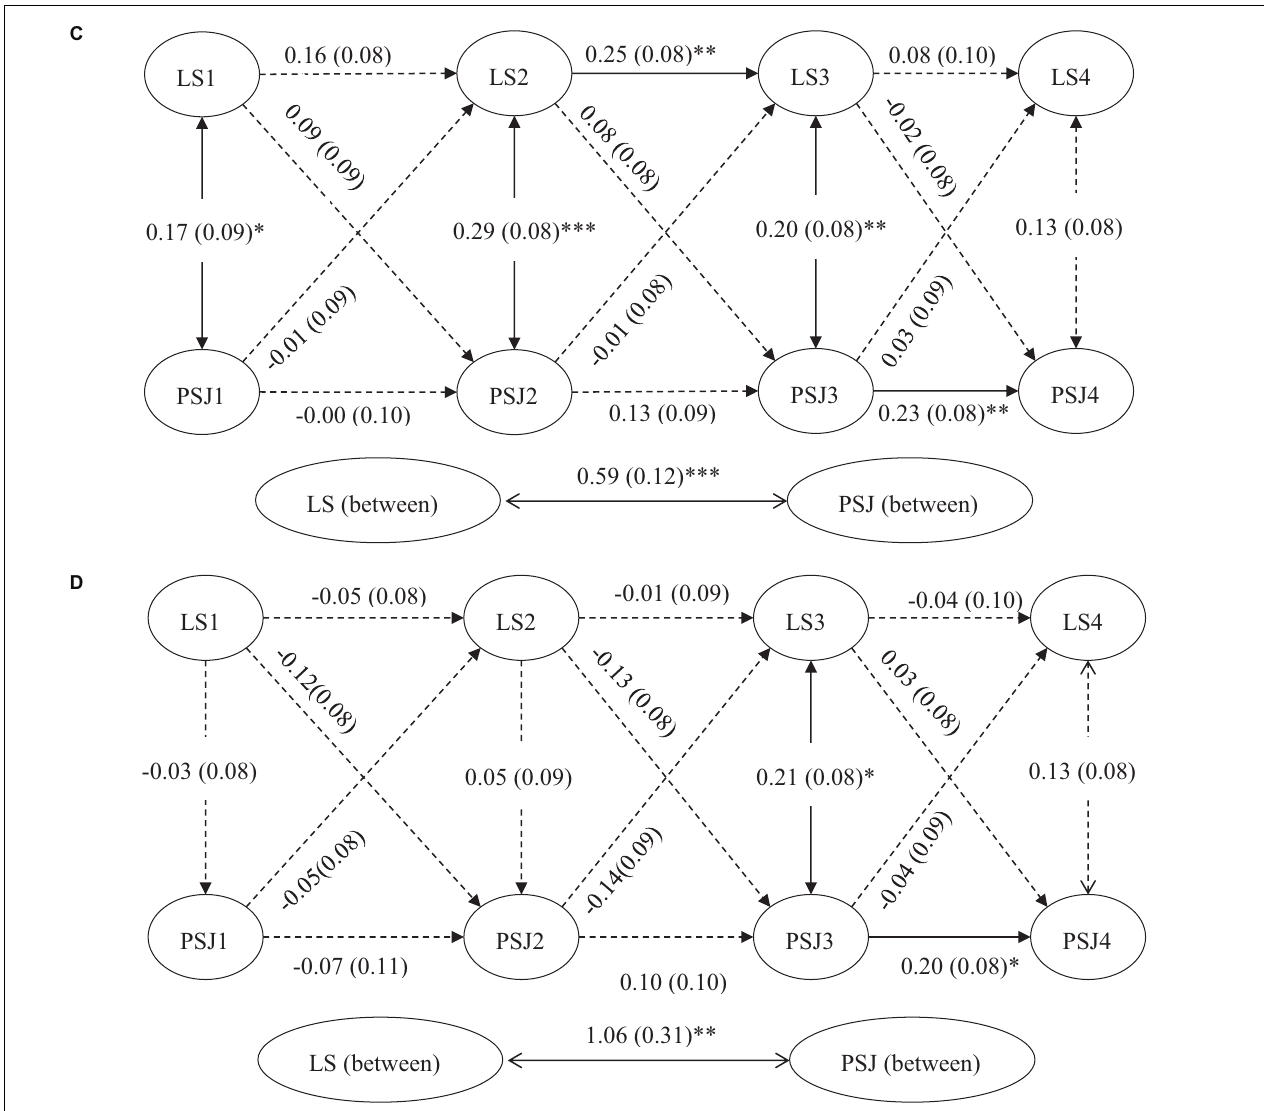
FIGURE 3 | Simplified random intercept cross-lagged panel model (RI-CLPM) in study 2 . * p < 0.05, ** p < 0.01, ∗∗∗ p < 0 . 001. (A) The whole sample, N = 637. (B) Low-income group, N = 198. (C) Middle-income group, N = 226. (D) High-income group, N = 213. LS 1–3 = life satisfaction of time 1 to time 3. PSJ 1–3 = perceived social justice of time 1 to time 3. Completely standardized parameter estimates are reported, with standard errors presented in